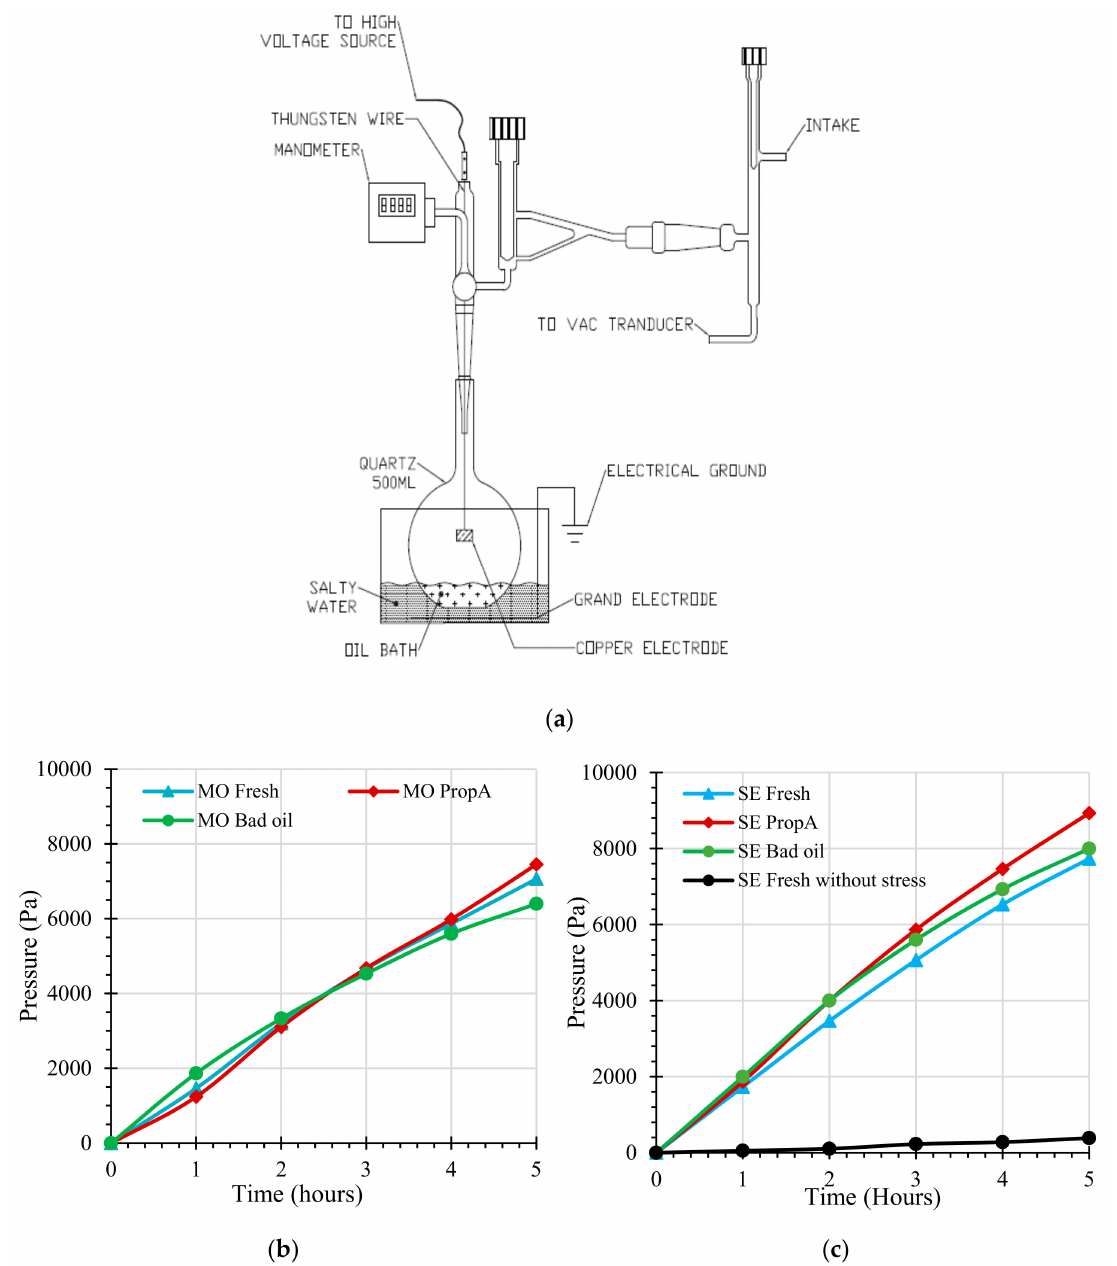
Figure 1. Illustration of experimental simulation of low energy discharges and change in pressure with discharge time: ( a ) setup to simulate low energy faults; ( b ) for mineral oil; ( c ) for synthetic